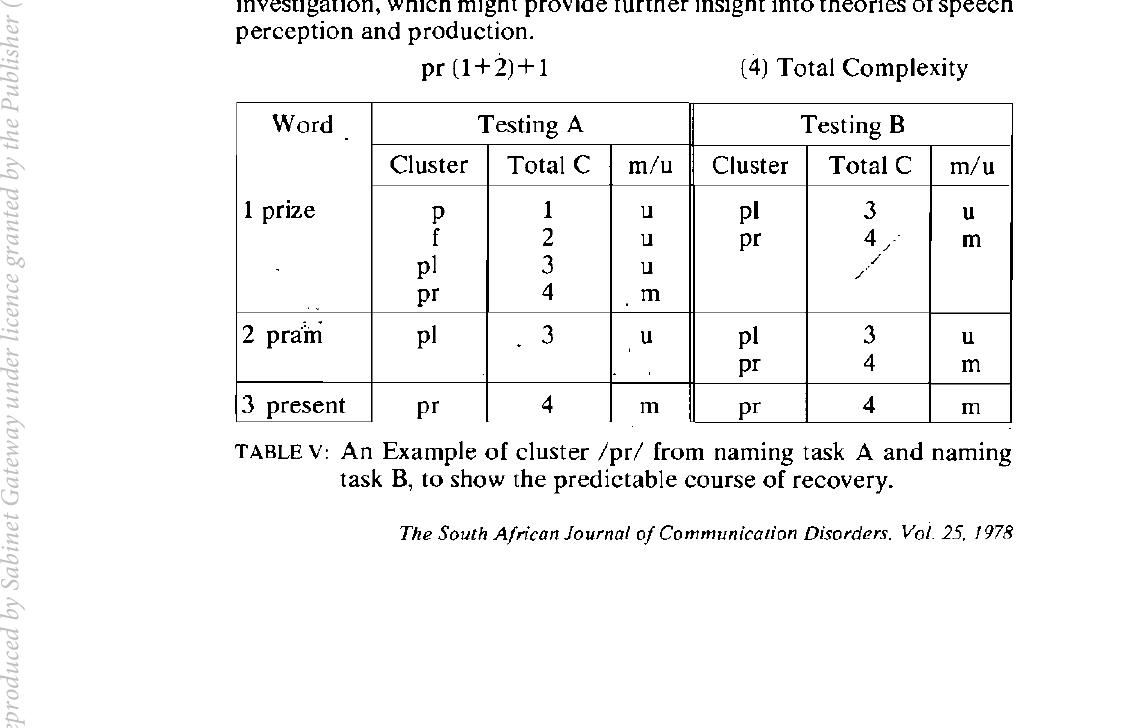
TABLE V: An Example of cluster /pr/ from naming task A and naming task B, to show the predictable course of